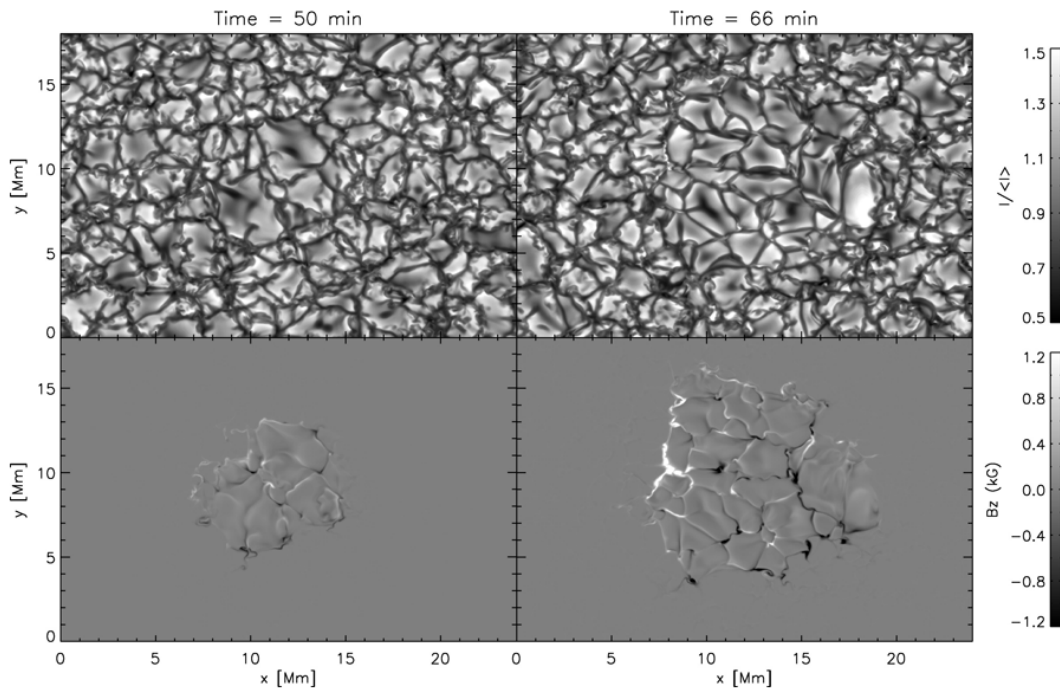
Figure 27: Continuum intensity images (top, at 5000 ˚A) and (bottom) synthetic magnetograms of a simulated emerging flux region. The snapshot at 𝑡 = 66 min shows the appearance of anomalously large granules and intergranular bright points in the emerging flux region. The magnetogram shows mixed polarity structures down to the granulation scale. Image reproduced with permission from Cheung et al. (2008), copyright by